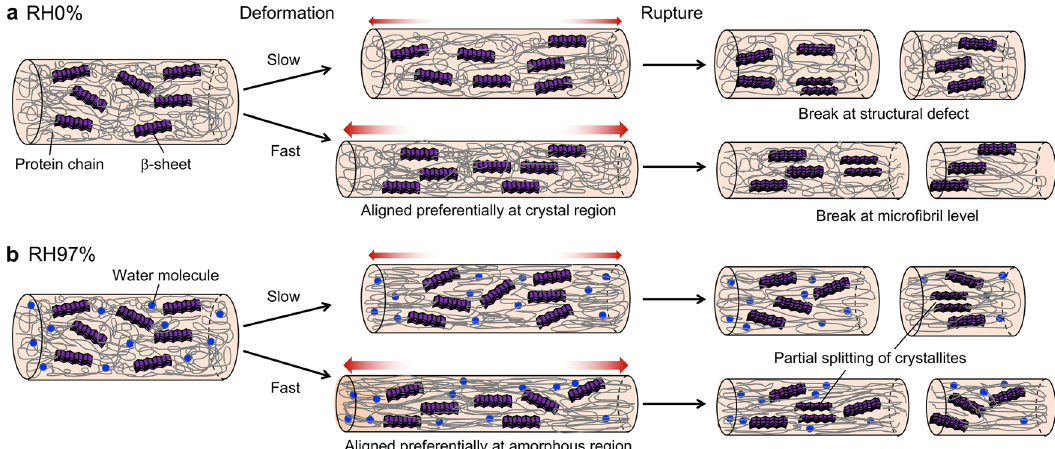
Fig. 10 A schematic model demonstrating microstructural changes of spider dragline silk fi bers at different strain rates and humidity. Silk molecular chains at crystal region deform and align along the fi ber axis at dry condition, whereas water molecules bind to amorphous regions and facilitate the molecular movement at wet condition. With further stretching, the crystallites start to split. The fracture surfaces would be detected at the structural defect at slower deformation rate, while the dragline silk could be broken at the micro fi bril level rather than at a macroscopic structural defect at faster deformation